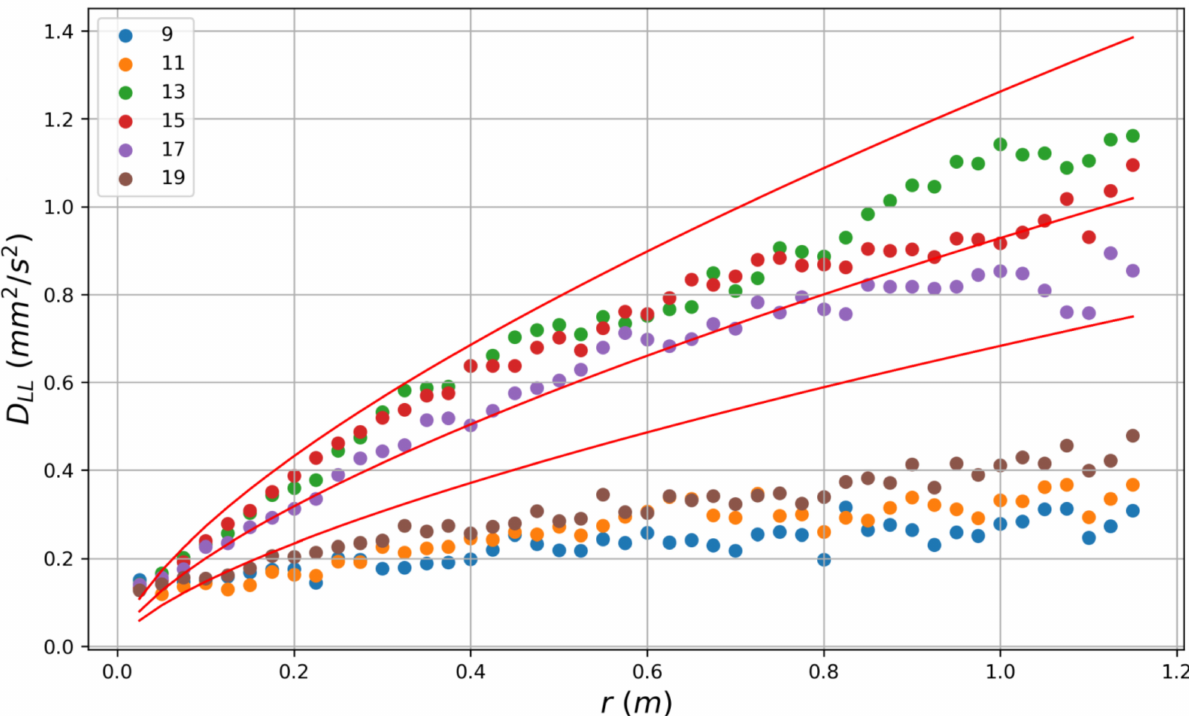
Figure 4. The set of longitudinal SF (averaged over six beams) calculated with a two-hour step for the time interval (09:00–18:00) 4 April 2020. Time averaging over 100 min. Solid lines represent the series of Kolmogorov curves D LL = C ε 2/3 r 2/3 with ε increasing from 0.2 · 10 − 9 to 0.5 · 10 − 9 . The labels correspond to the measurement time